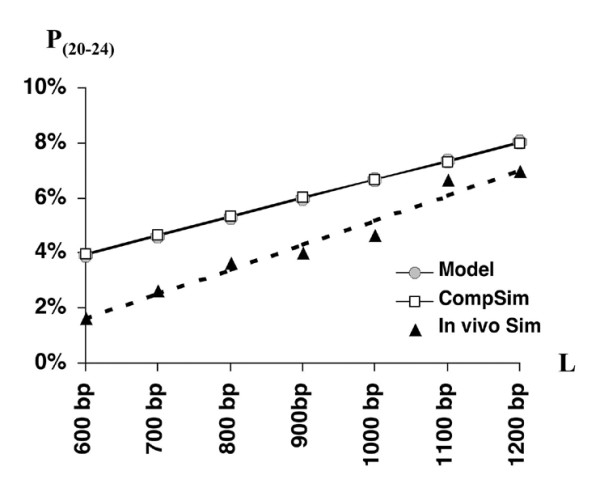
Probability of finding one or more quasi-ditag in the nucleotide sequence of a given length (L = 600 to 1200 bp). Model, mathematical modeling; CompSim, computer simulation (1,000,000 simulations for each L value); In vivo Sim, fragments of S. Cerevisiae chromosomes (300 simulations for each L value). Dotted line represents trendline for In vivo Sim.